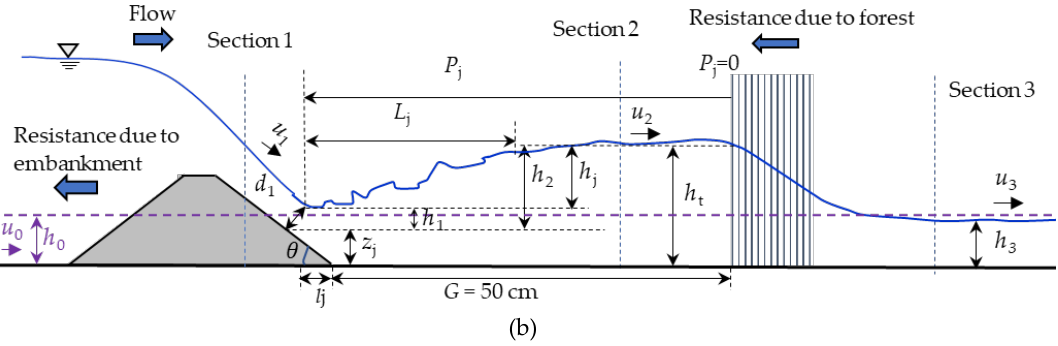
Figure 2. Sketch of the hydraulic jump type and definition of hydraulic jump parameters: ( a ) Jump occurs on the floor between the embankment and forest models (Type A) and ( b ) jump occurs on the downslope of the embankment model (Type-B).